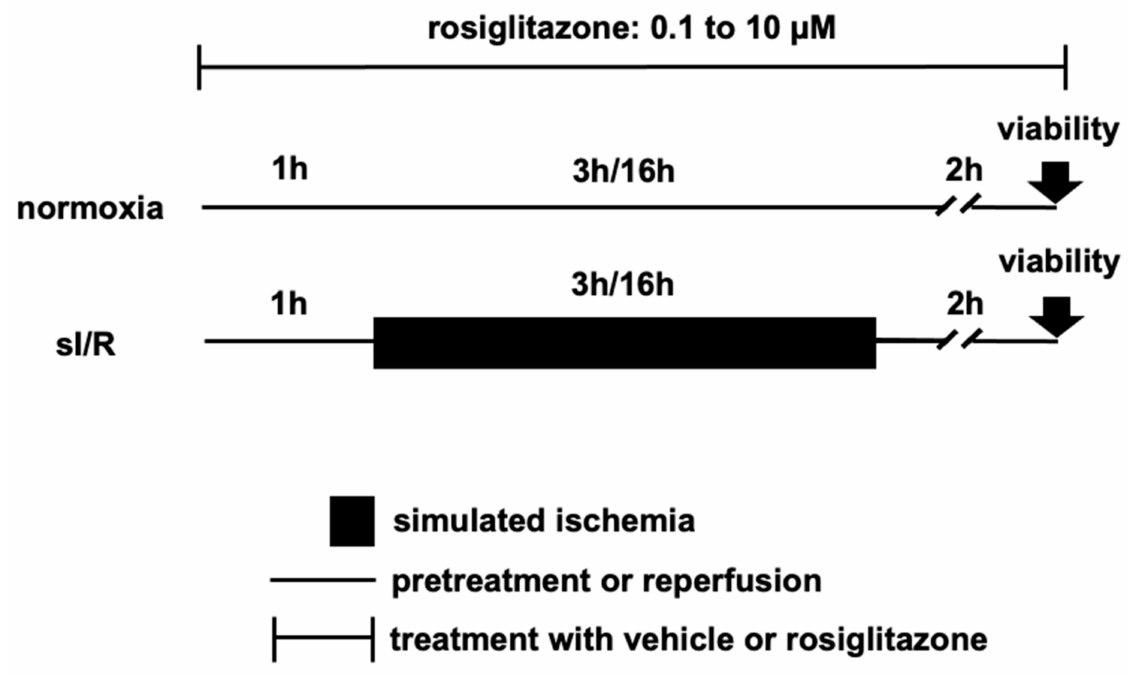
Figure 5. Experimental protocols of simulated ischemia/reperfusion injury with different rosigli- tazone concentrations in vitro. ARCMs were exposed to three hours of simulated ischemia followed by 2 h of simulated reperfusion, whereas the immortal AC16 and differentiated AC16 cells were subjected to 16 h of simulated ischemia followed by 2 h of simulated reperfusion. sI/R : simulated